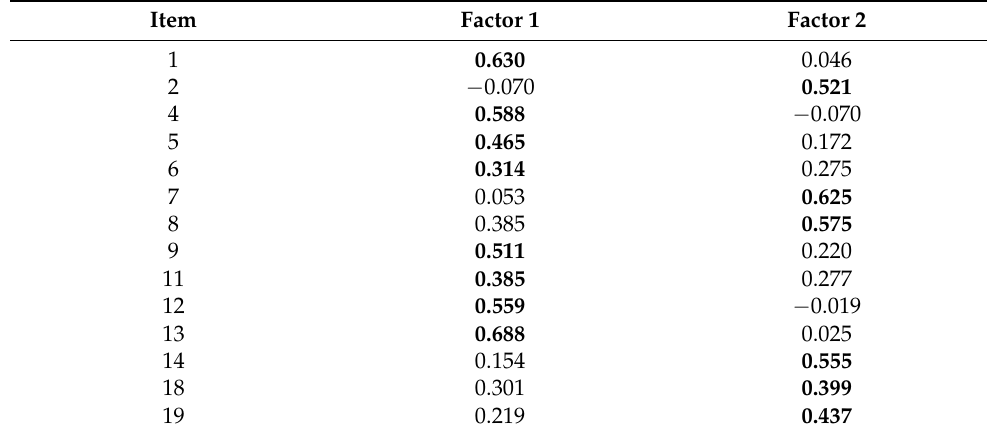
Table 1. Pattern matrices of the concern for health consequences of ABR risk scale and the denial of ABR risk scale (EFA—Principal Component Analysis, Varimax rotation).